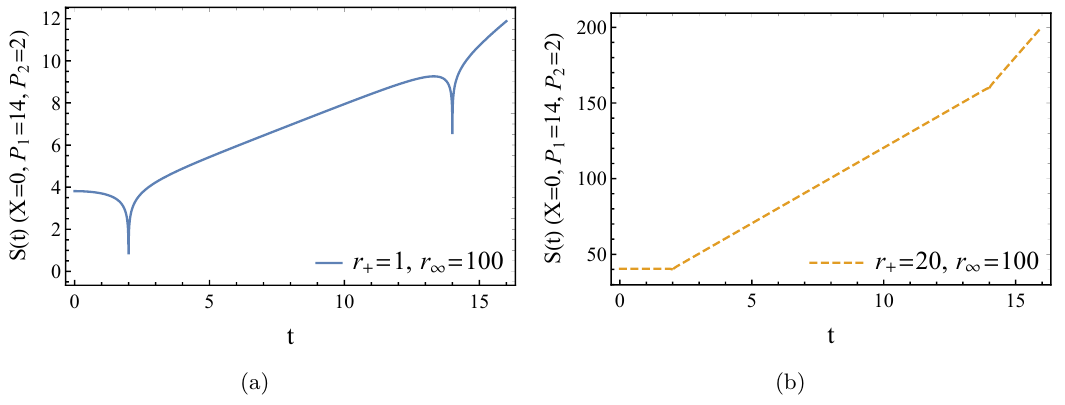
Figure 12 . Time dependence of the holographic entanglement entropy given by (5.17) (with 4 G = 1 ) for small and large r N r ∞ = 100 . For the plot, we recover the constant term 1